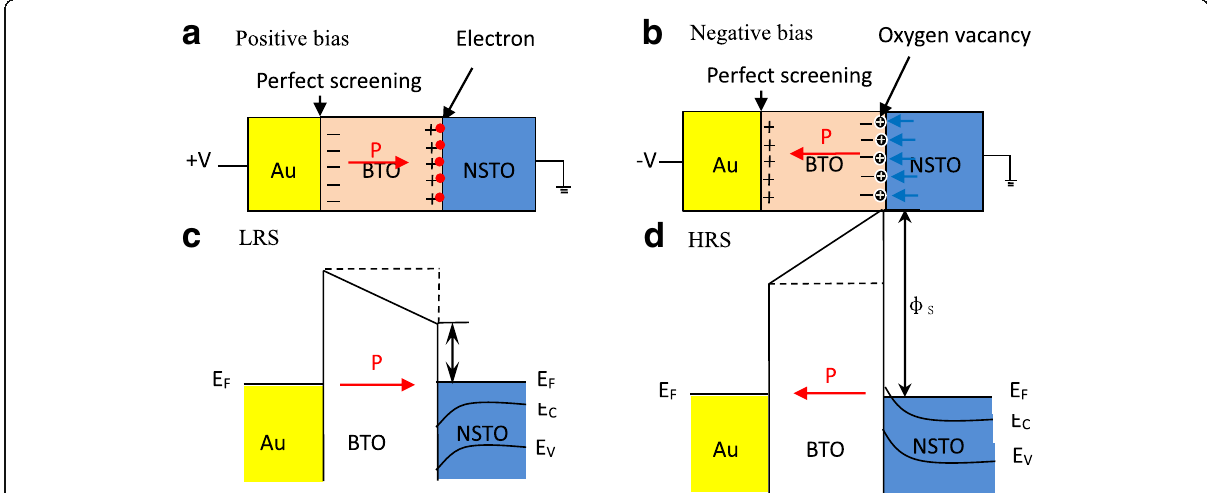
Fig. 3 The schematic drawings ( a , b ) and corresponding potential energy profiles ( c , d ) of the Au/BTO/NSTO structures for the low- and high-resistance states. In BTO, the red arrows denote the polarization directions, and the “ plus ” and “ minus ” symbols represent positive and negative ferroelectric bound charges, respectively. The “ circled plus ” symbols represent the ionized oxygen vacancies. The blue arrows show the direction of oxygen vacancies drifting across the BTO/NSTO